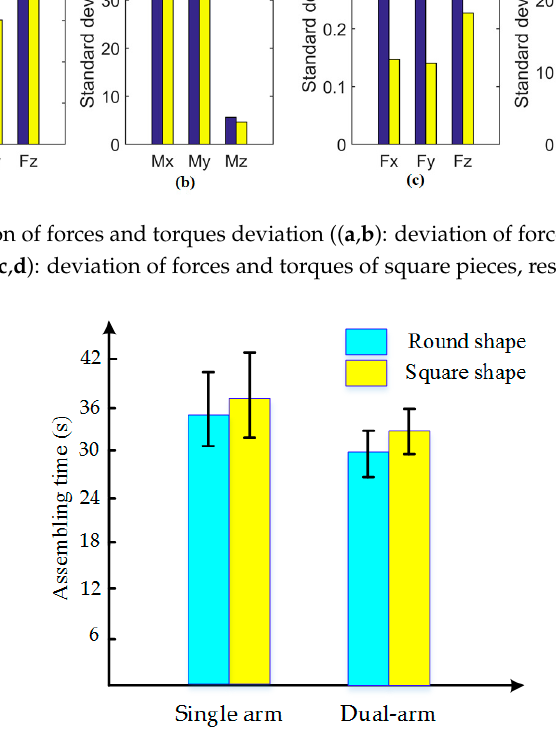
Figure 21. Assembling time for single-arm operation and dual-arm operation.